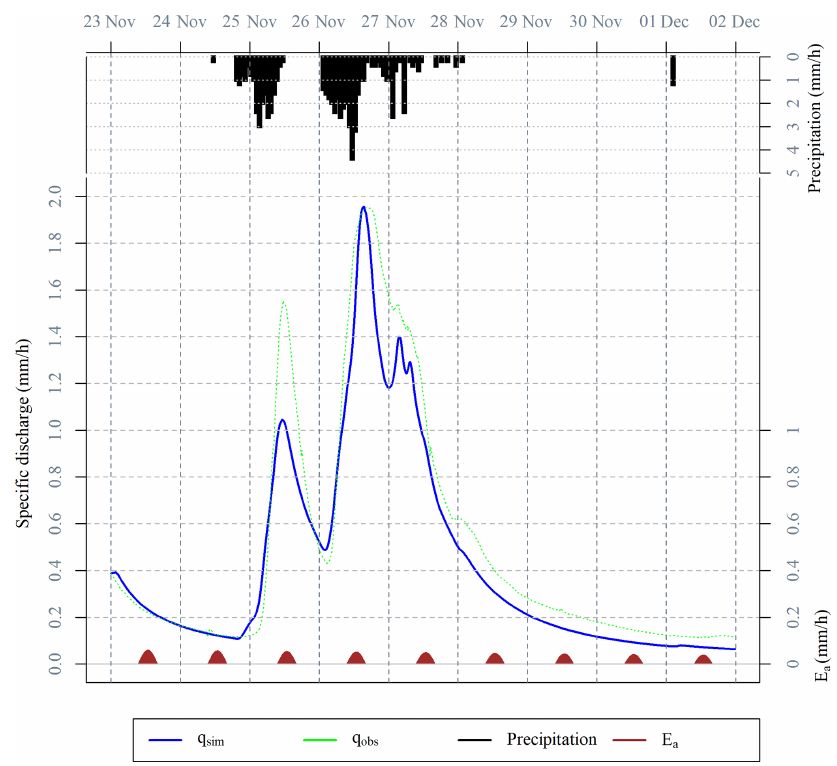
Figure A2. Example of a plot enabled by the dynatopmodel package. This example was generated by using the data set included in the package. This figure combines plots of actual evapotranspiration time series, precipitation time series and simulated and observed